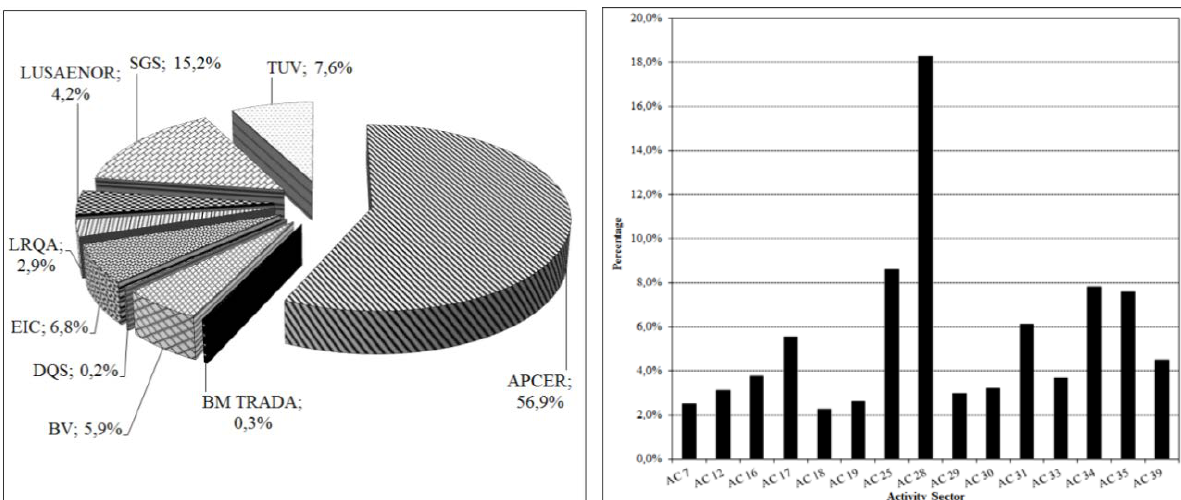
Figure 5. Certification entities more involved with OHSMSs (Portugal).